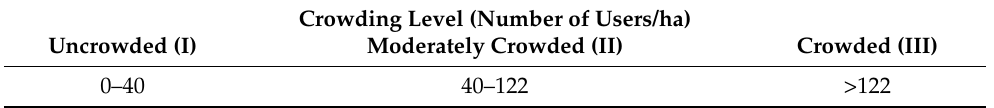
Table 3. The crowding level classification standard of open public